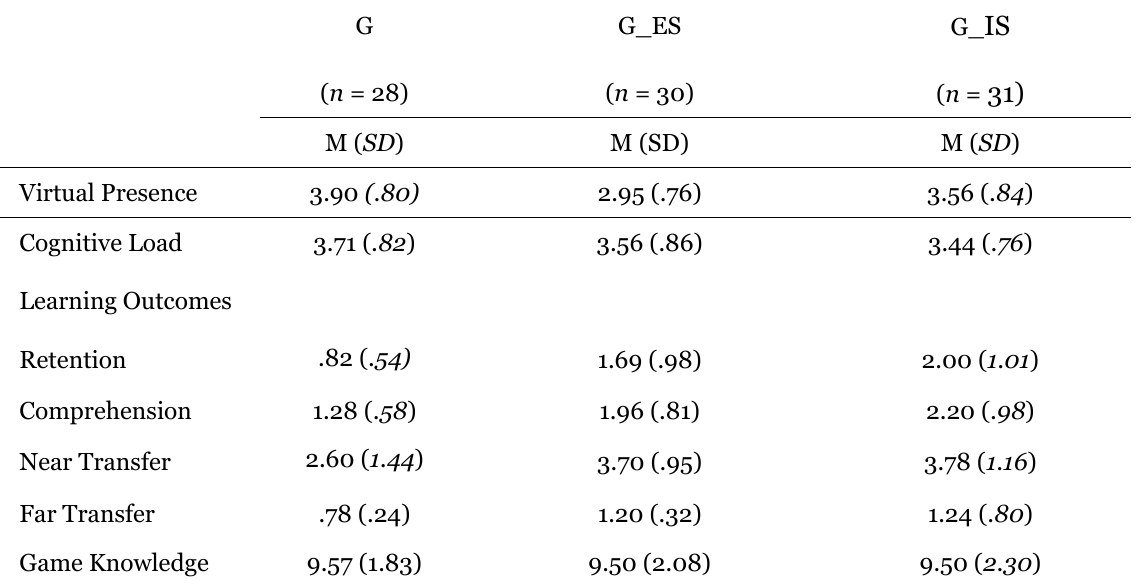
Means (and Standard Deviations) for Virtual Presence, Cognitive Load, and Sum Scores for Learning Outcomes of the Three